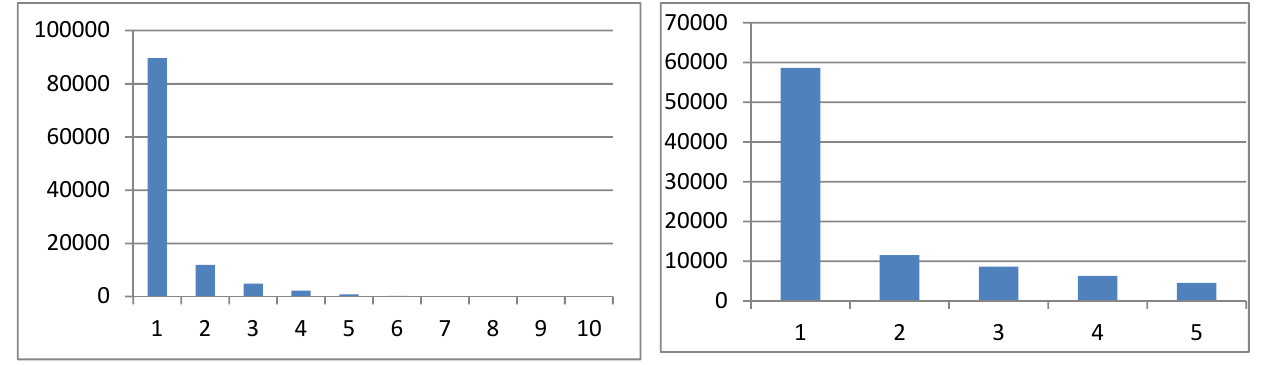
Fig. 1. Daily cash withdraw ATMs distribution Fig. 2. ATMs Daily Cash Withdraw Distribution